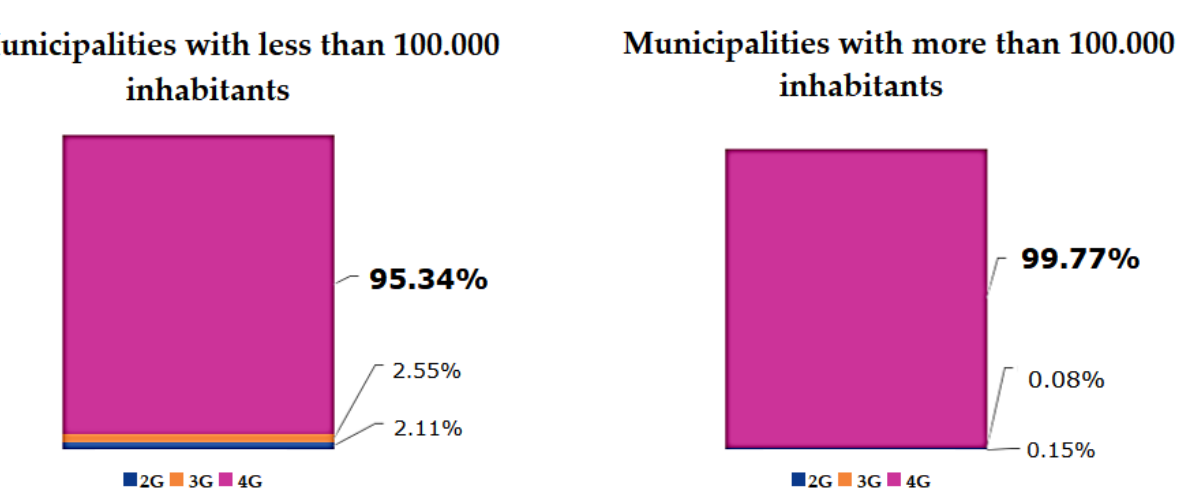
Figure 3. Coverage of 2G, 3G, and 4G technologies in Colombia. Source : [50].